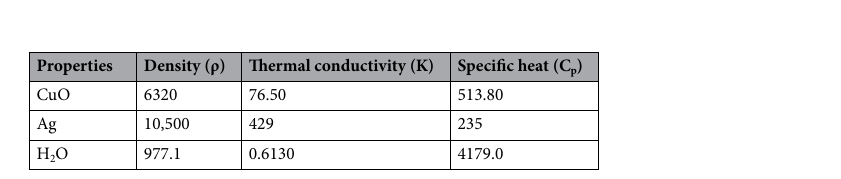
Table 2. Thermo-Physical Qualities of Nanoparticles (CuO, Ag) and Base Liquid H 2